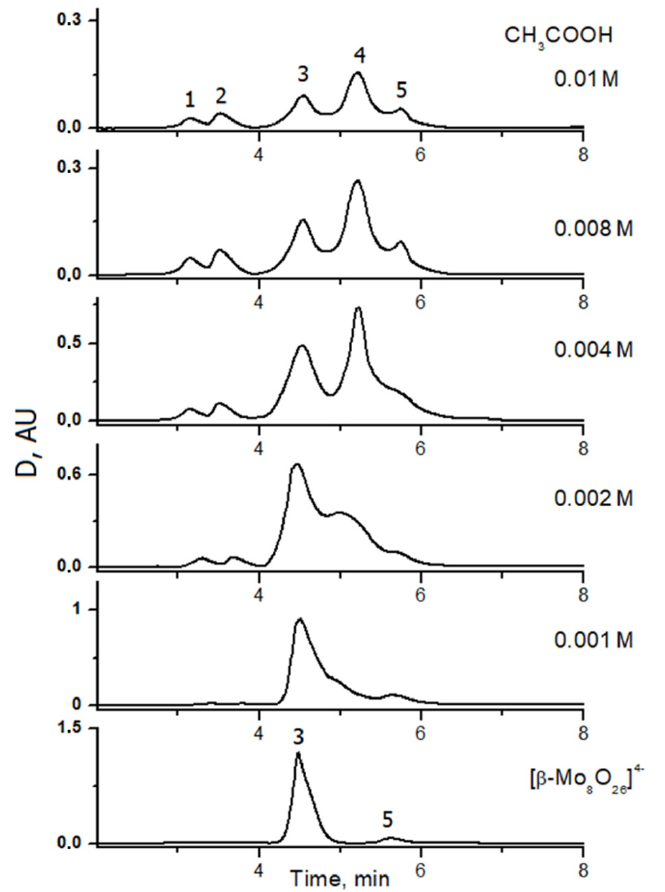
Figure 7. The HPLC ‐ UV chromatograms of (Bu 4 N) 4 [ β‐ Mo 8 O 26 ] in dimethyl sulfoxide with the addi ‐ Figure 7. The HPLC-UV chromatograms of (Bu 4 N) 4 [ β -Mo 8 O 26 ] in dimethyl sulfoxide with the tion of acetic acid. addition of acetic